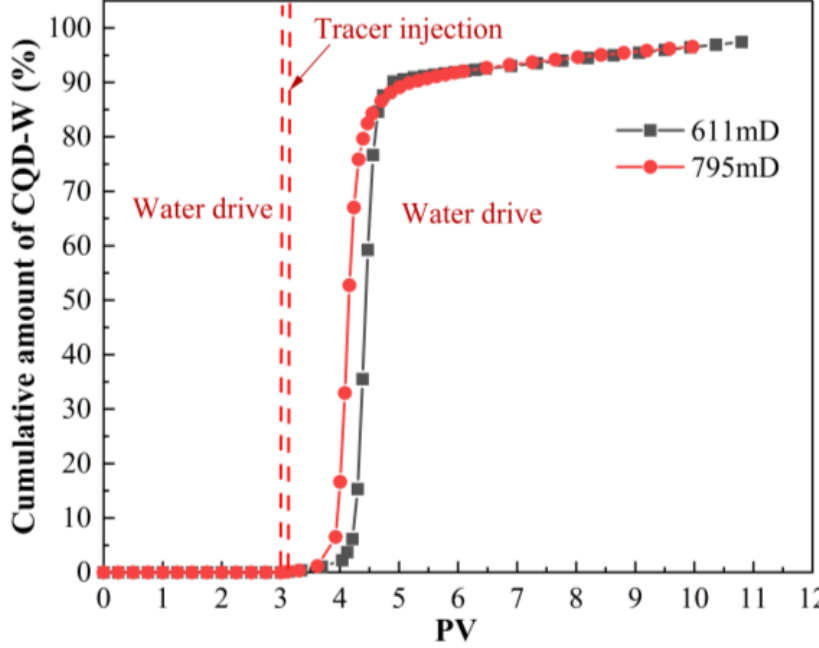
Figure 15. The cumulative volume of CQD-W versus injection volume.